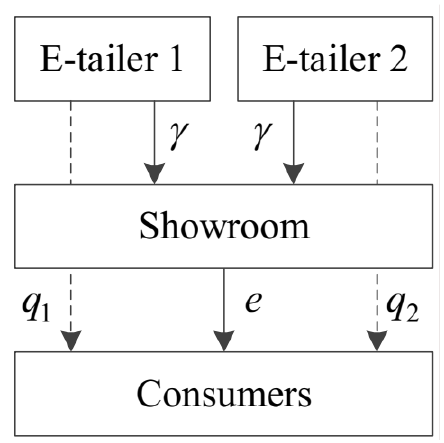
Figure 1. Supply chain